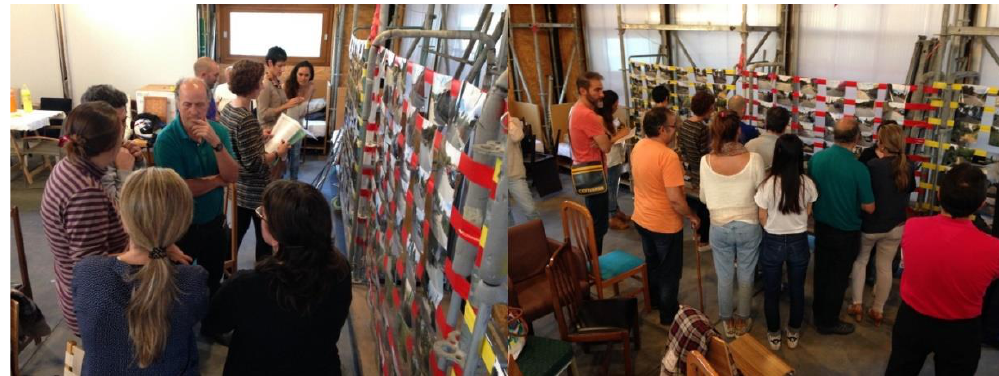
Figure 4. Participatory workshop with the neighbours (September 2017) .